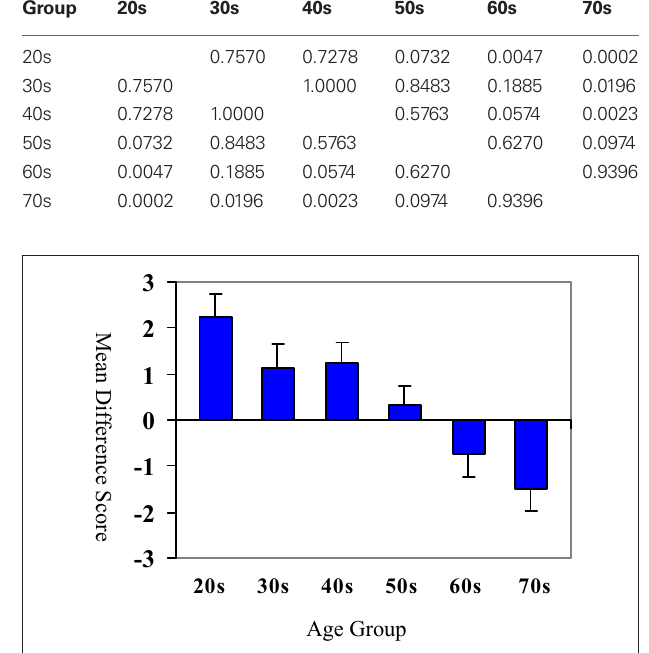
Table 2 | P -values of differences in all pairwise comparisons between age groups.